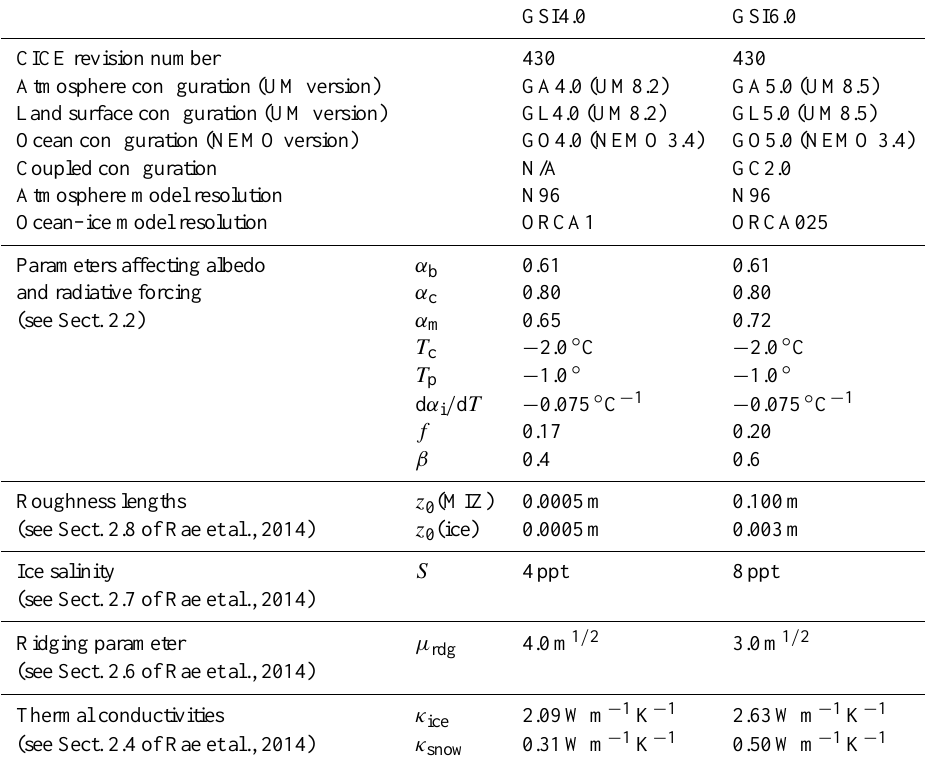
Table 1. Model set-up and values of sea ice parameters in GSI4.0 and GSI6.0